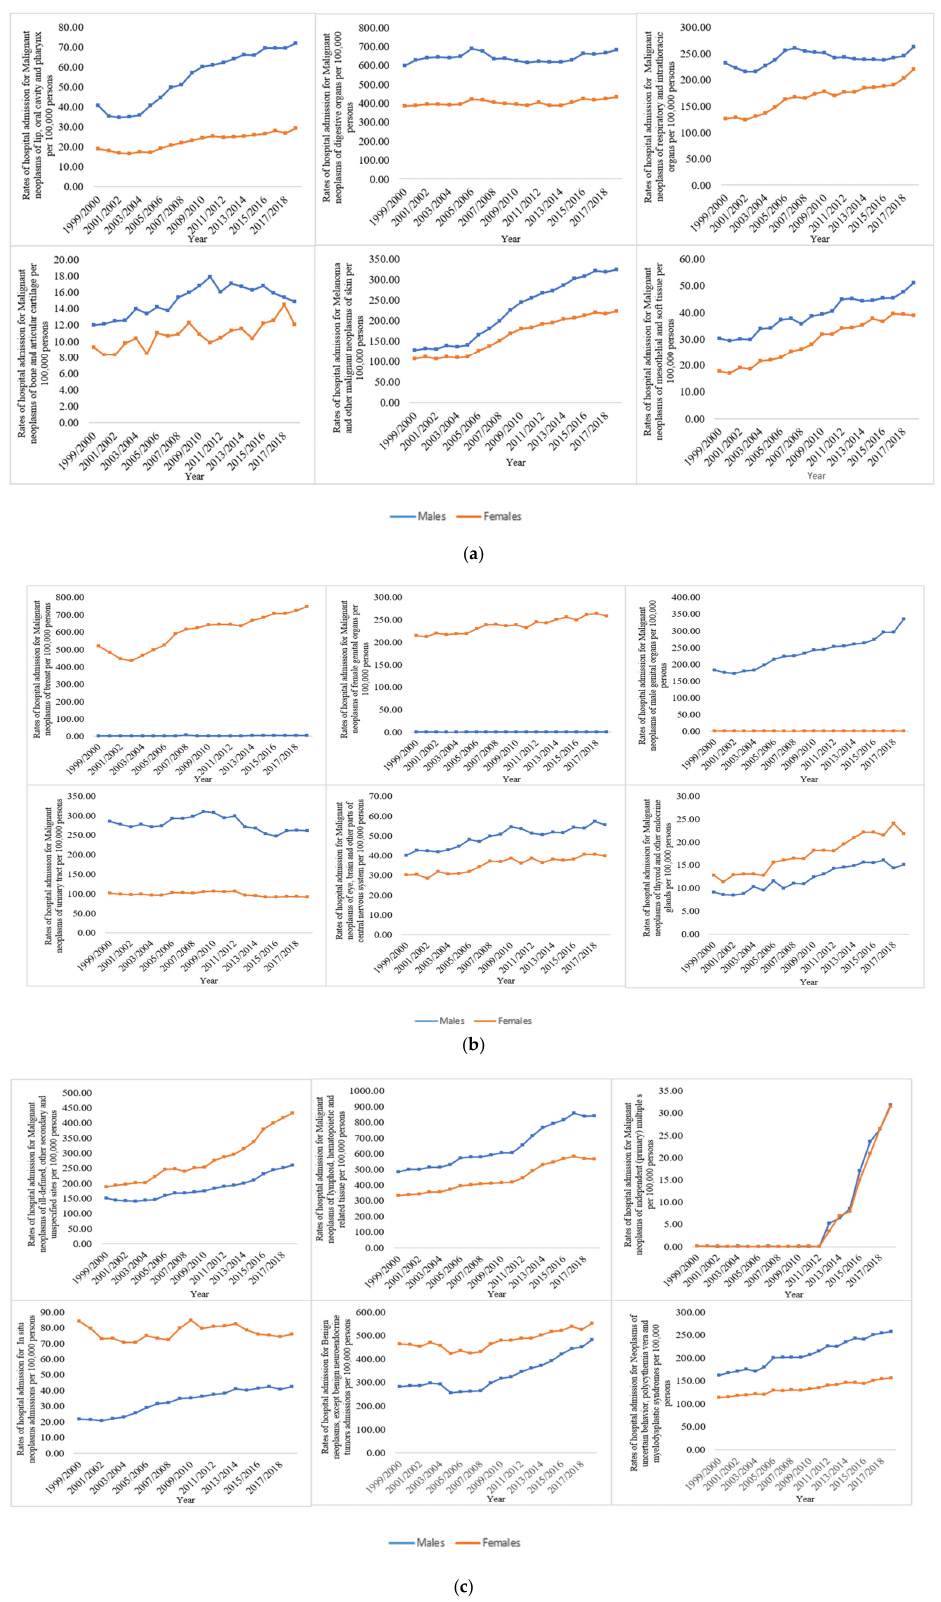
Figure 3. ( a ) Hospital admission rates for neoplasms in England and Wales stratified by gender between 1999 and 2019; ( b ) Hospital admission rates for neoplasms stratified by gender (continued); ( c ) Hospital admission rates for neoplasms stratified by gender (continued).